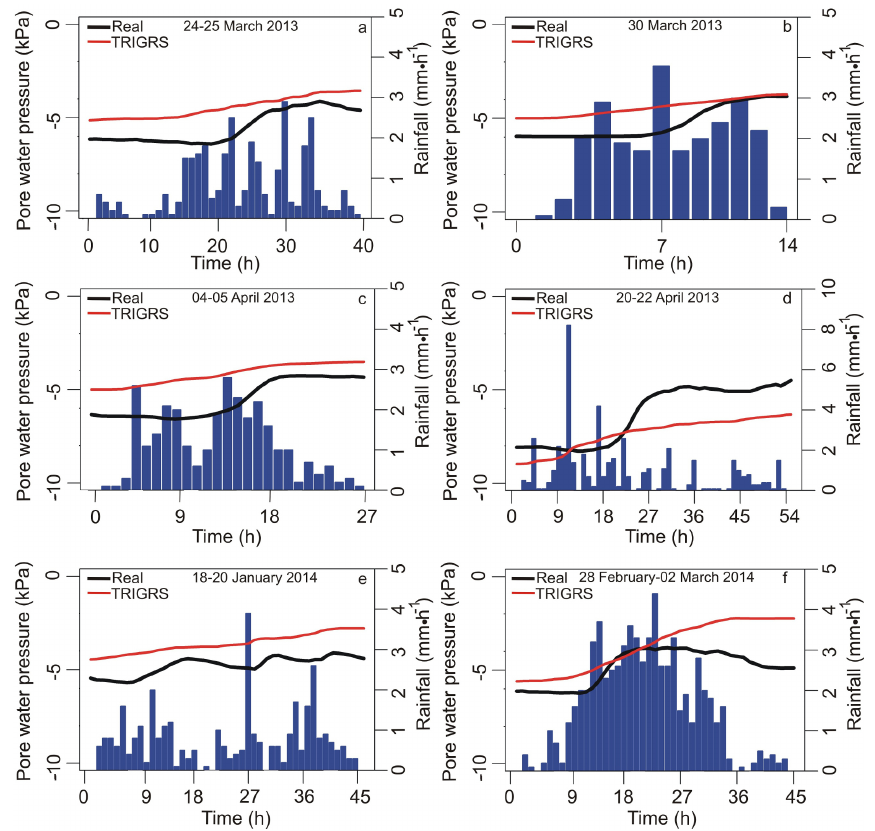
Figure 9. Comparison of measured and estimated TRIGRS-unsaturated pore water pressure trends at 0.6m from ground corresponding to the monitoring station for selected rainfall events: (a) 23–25 March 2013; (b) 30 March 2013; (c) 4–5 April 2013; (d) 20–22 April 2013; (e) 18–20 January 2014; (f) 28 February–2 March